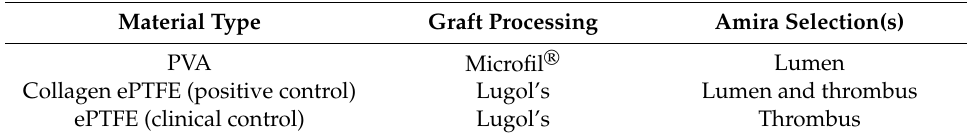
Table 1. Summary of material processing. Biomaterials were rendered radiopaque in different ways on the basis of their material properties.